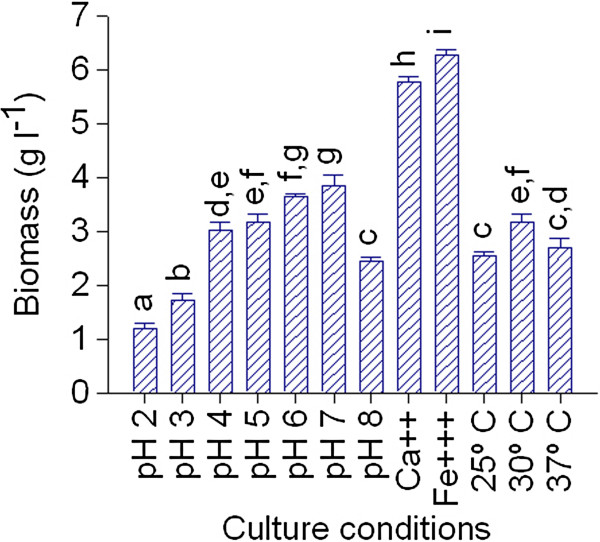
Biomass production during a submerged process of A. niger MYA 135 under different culture conditions. Error bars represent the standard deviation calculated from at least three independent experiments. Bars with the same letter are not significantly different. These data were obtained after 72 h of cultivation.